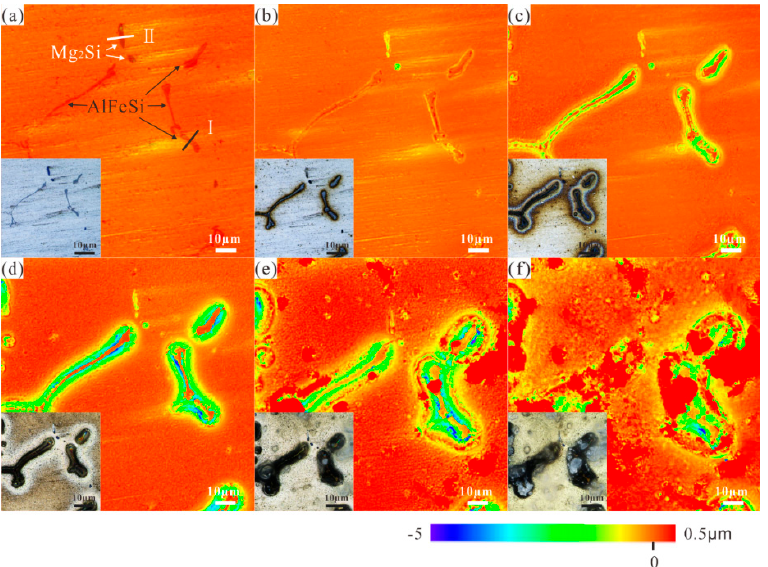
Figure 7. Corrosion morphologies of Al alloys aged 5 h at 180 °C immersed in 3.5% NaCl solution for different times: ( a ) 0 h, ( b ) 1 h, ( c ) 8 h, ( d ) 24 h, ( e ) 72 h, and ( f ) 120 h.